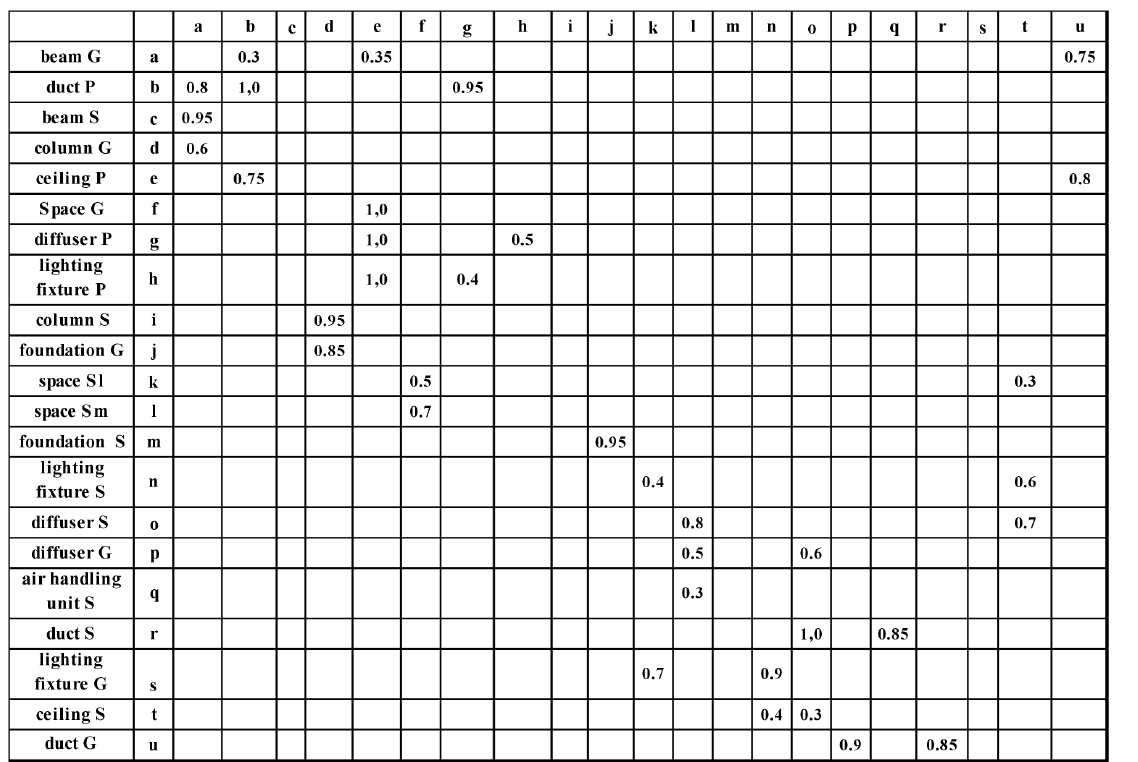
Fig. 9. The dependency relations DSM